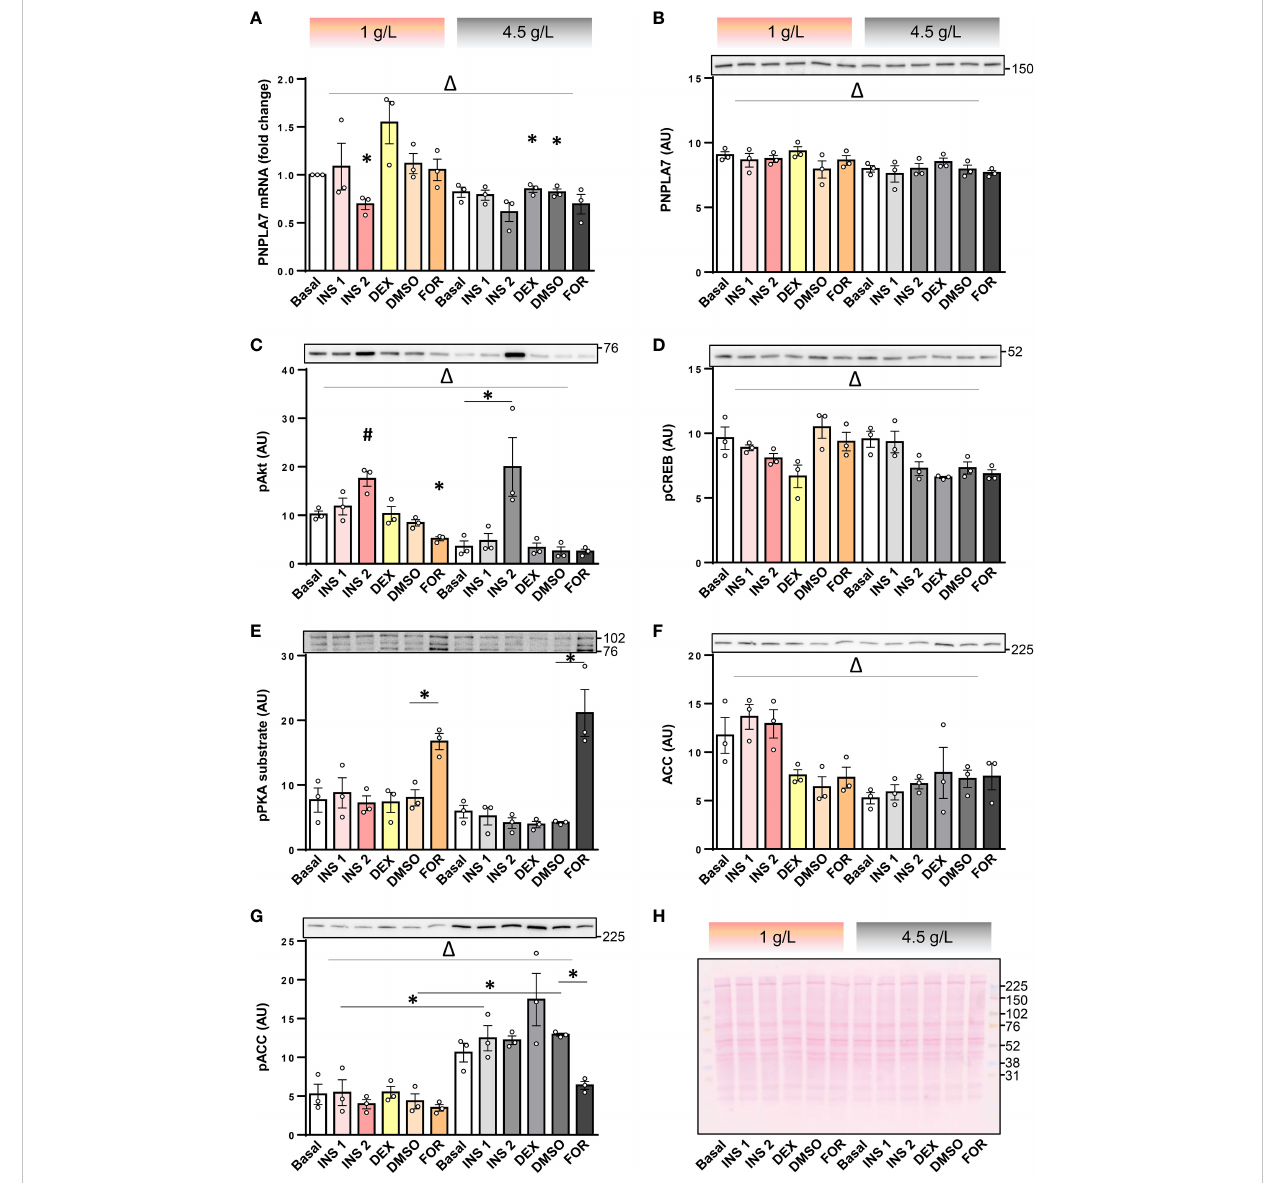
FIGURE 3 Effect of insulin, dexamethasone, forskolin, and glucose on the PNPLA7 expression in cultured human myotubes. (A – G) Human skeletal muscle cells were differentiated for 8-10 days in Advanced MEM with 2% FBS. For the last 16 h of the experiment cells were grown in the serum-free DMEM with two different glucose concentrations (1 g/L and 4.5 g/L; marked at the top with pink and grey colour code, respectively), and exposed to insulin (0.1 µg/mL; INS1, or 10 m g/mL; INS2), dexamethasone (1 m M; DEX), or forskolin (5 µM in DMSO; FOR), or DMSO (0.05 v/v %). (A) The mRNA levels of PNPLA7 were measured by qPCR and are presented as geometric mean of expression ratios against two reference genes (18S rRNA and ACTB). (B – G) Protein levels of (B) PNPLA7, (C) phospho-Akt Ser 473 , (D) phospho-CREB Ser 133 , (E) phospho-PKA substrate, (F) ACC, and (G) phospho-ACC Ser 79 , were estimated by immunoblotting (representative blots are shown above the charts with indicated positions of molecular weight markers; kDa). (H) A representative Ponceau-stained membrane. Actin blots, which were used as an additional loading control are shown in the corresponding Supplementary Figure. Results are means with SEM (n = 3). *p < 0.05 vs. Basal-1 g/L glucose or as indicated. D p < 0.05 between 1 g/L and 4.5 g/L glucose (two-way ANOVA), #Dunnett test vs.